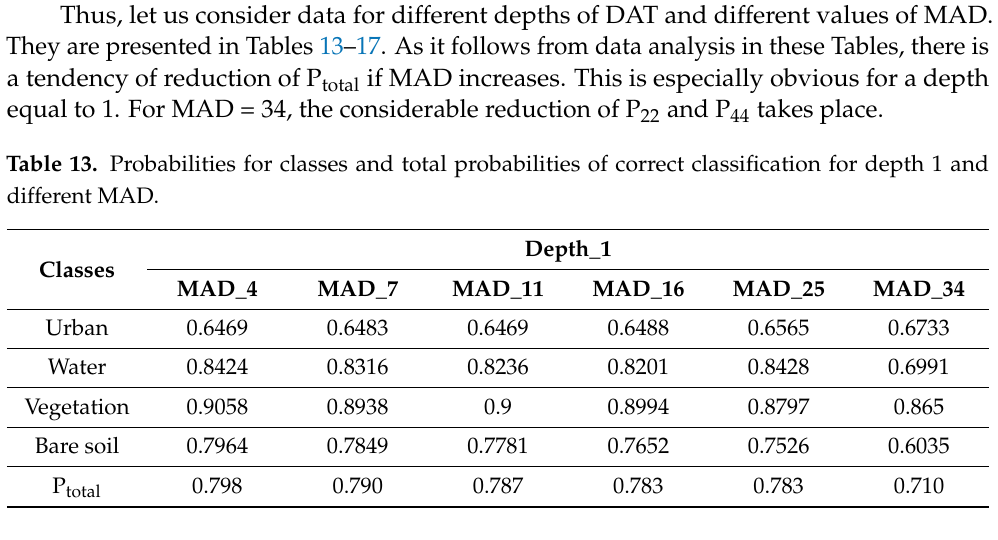
Table 14. Probabilities for classes and total probabilities of correct classification for depth 2 and different